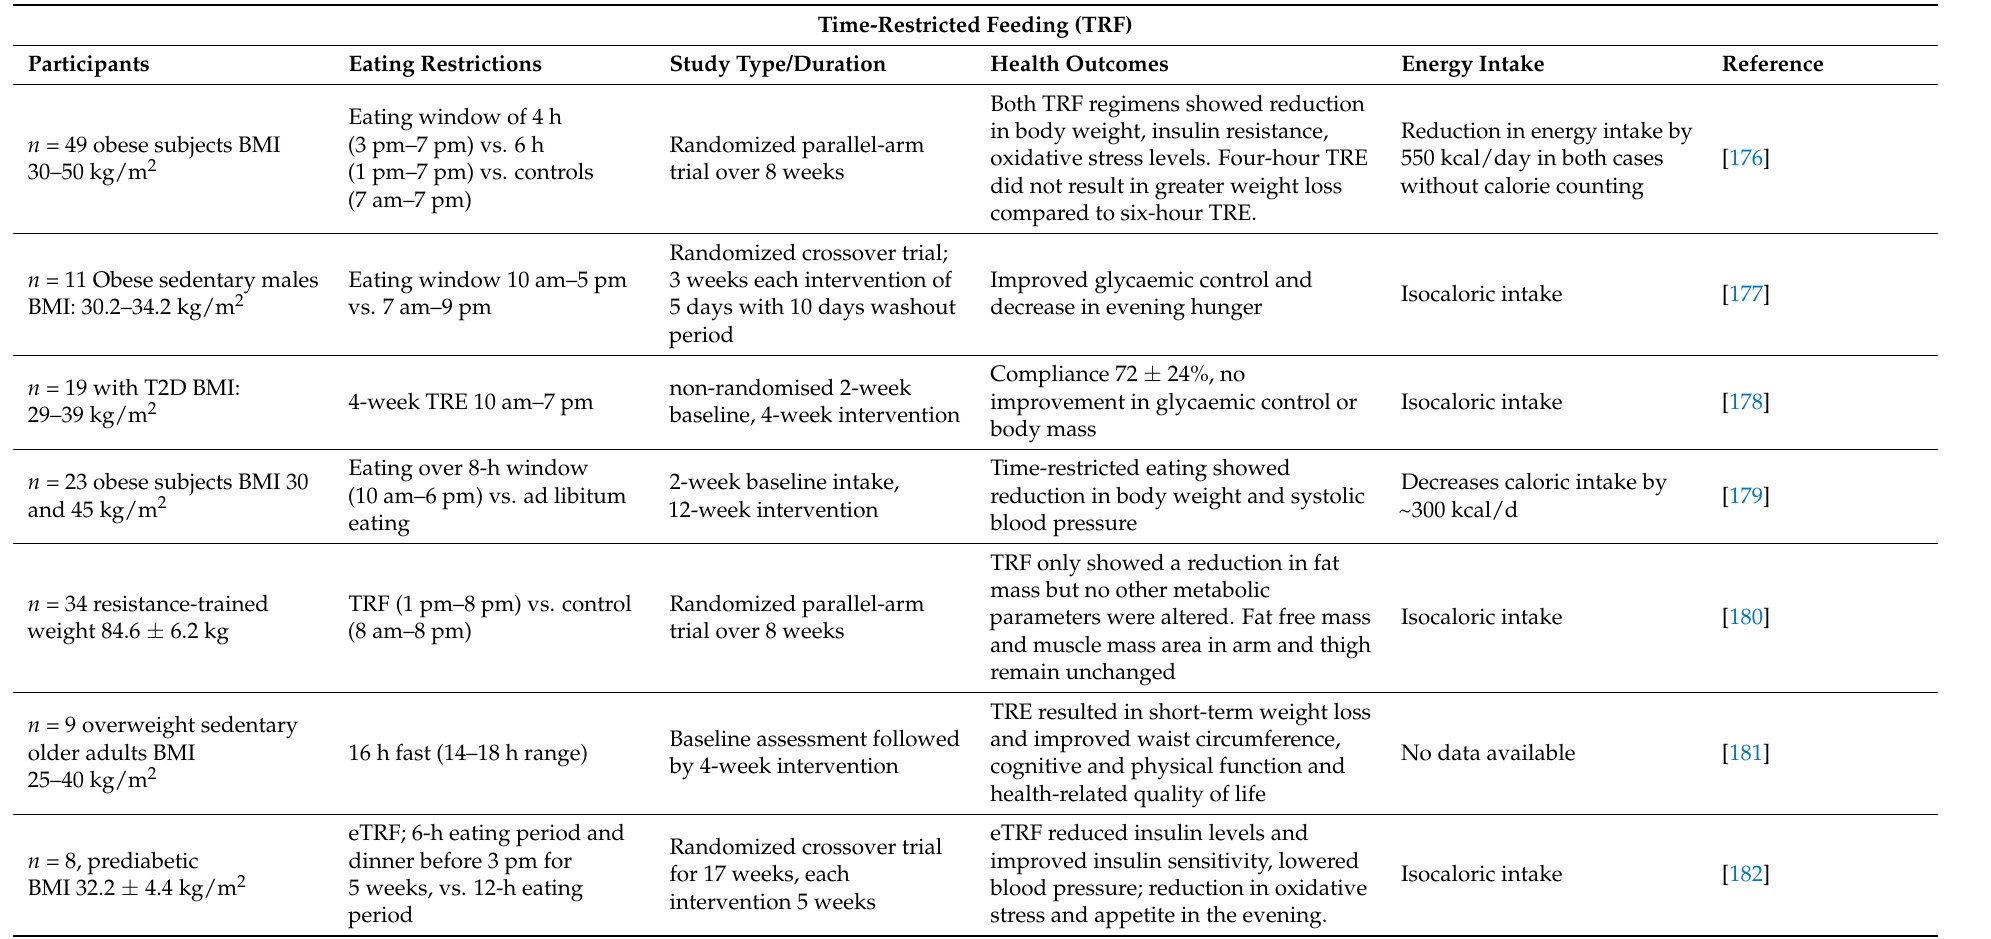
Table 4. A summary of human studies investigating the impact of time-restricted eating in humans and metabolic health outcomes. Time-Restricted Feeding